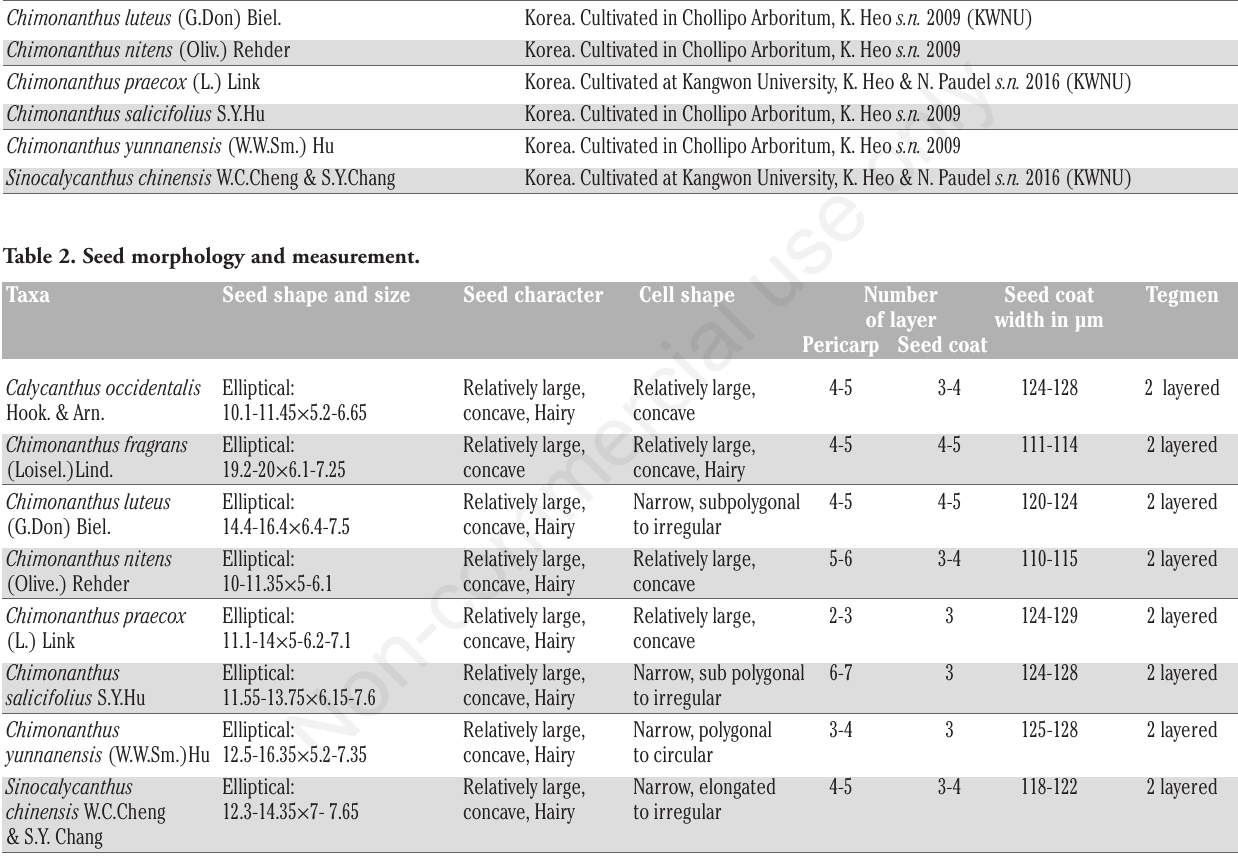
Table 1. Collection information of genus and species used in present study.